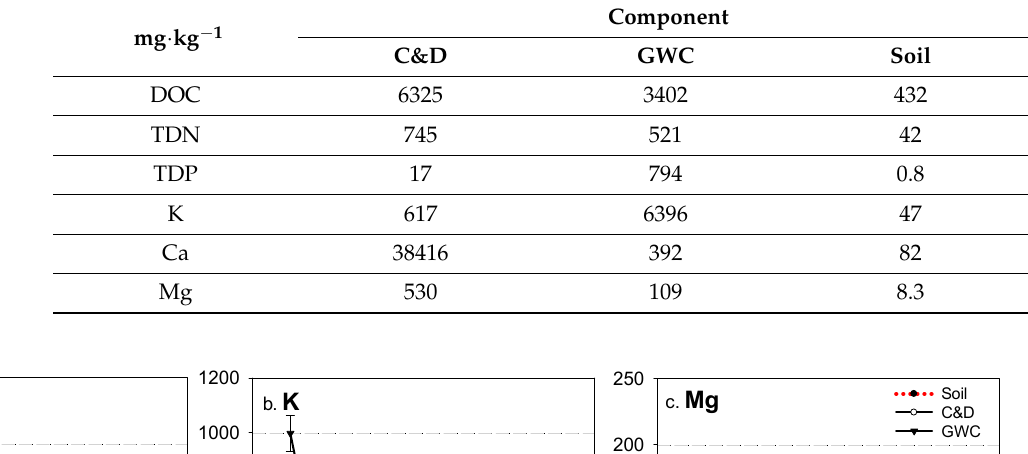
Table 2. Total accumulated removal of dissolved organic carbon (DOC), total dissolved nitrogen (TDN), total dissolved phosphorus (TDP) and other selected elements as determined by the column leaching test (mg · kg − 1 ). Values are mean of duplicate columns; for selected leachate concentration data, see Figure 1.